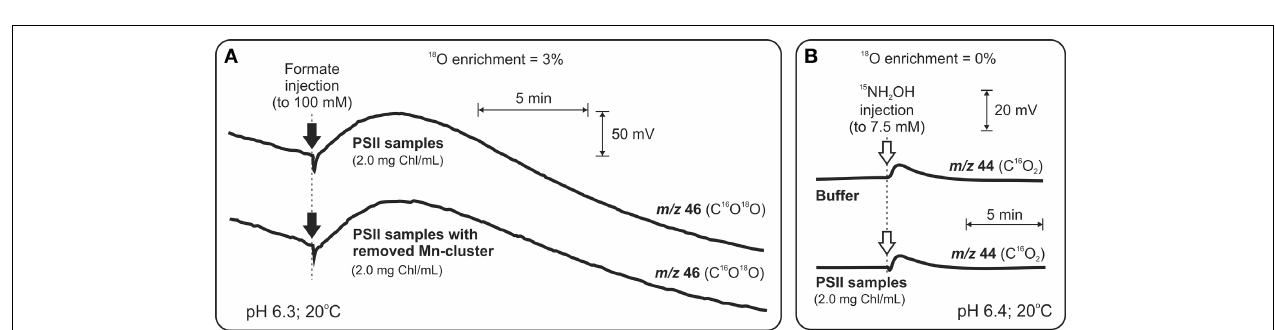
reduction of the Mn 4 CaO 5 cluster and release of Mn ions as Mn II into the solution didn’t lead to a release of CO 2 /HCO − 3 above background. In order to avoid the overlay of CO 2 and N 2 O signals (the latter is known to be produced during interaction of NH 2 OH with the Mn 4 CaO 4 cluster), the N 2 O signal was shifted from m/z 44 to m/z 46 by employing the 15 N-labeled NH 2 OH for these experiments. To facilitate equilibration between CO 2 and HCO − 3 all measurements were performed in the presence of externally added CA (to a final concentration of 3 μ g ml − 1 ). Modified from Shevela et al.